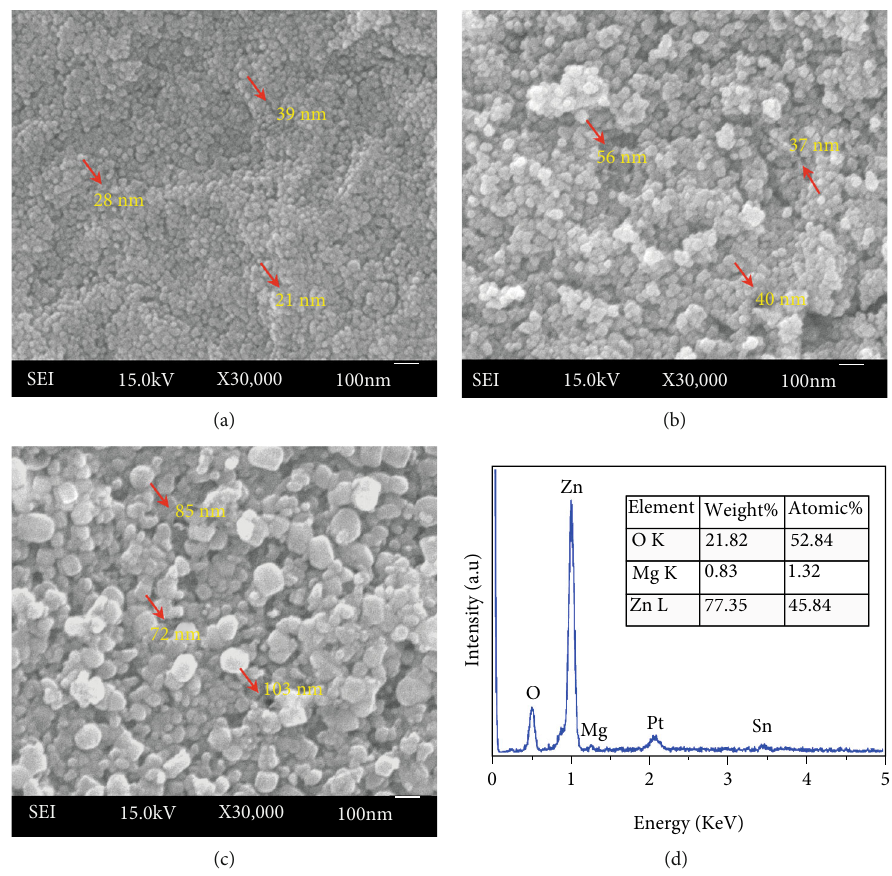
Figure 2: Scanning electron microscope images of Mg-doped ZnO with variation of annealing temperatures: (a) 400, (b) 500, (c) 550, and (d) representative EDS